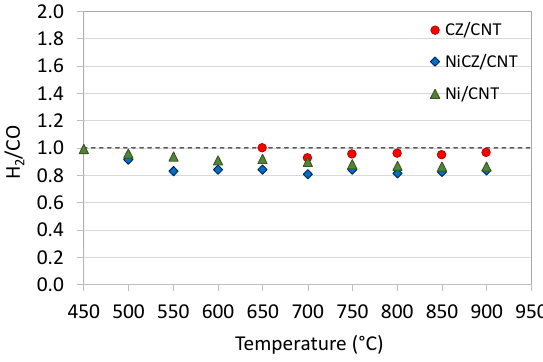
Figure 10. The H 2 / CO ratio during DRM over CZ / CNT, NiCZ / CNT and Ni / CNT catalysts.